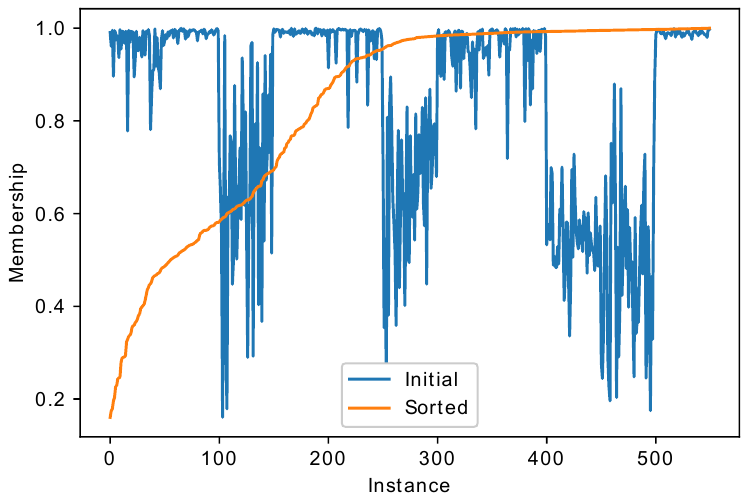
Figure 3. Fuzzy membership values returned by HEFCA algorithm, texture dataset, test set.